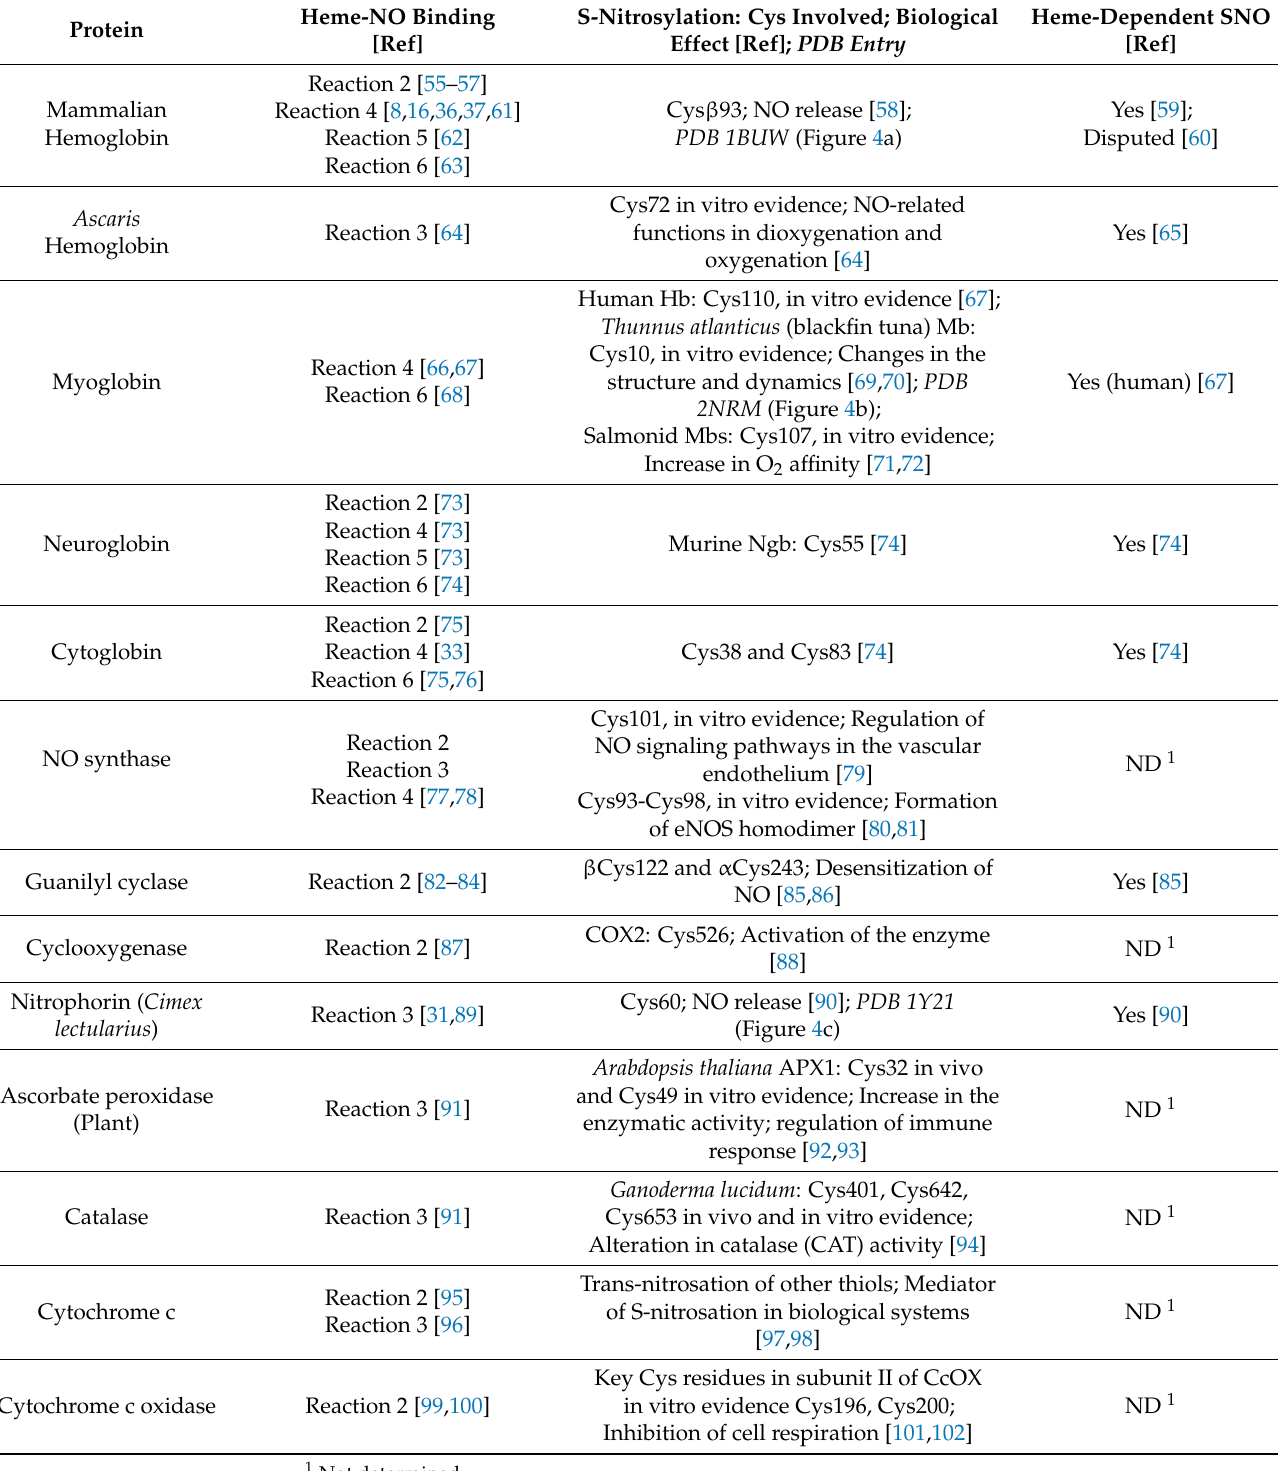
Table 1. List of heme proteins discussed in this